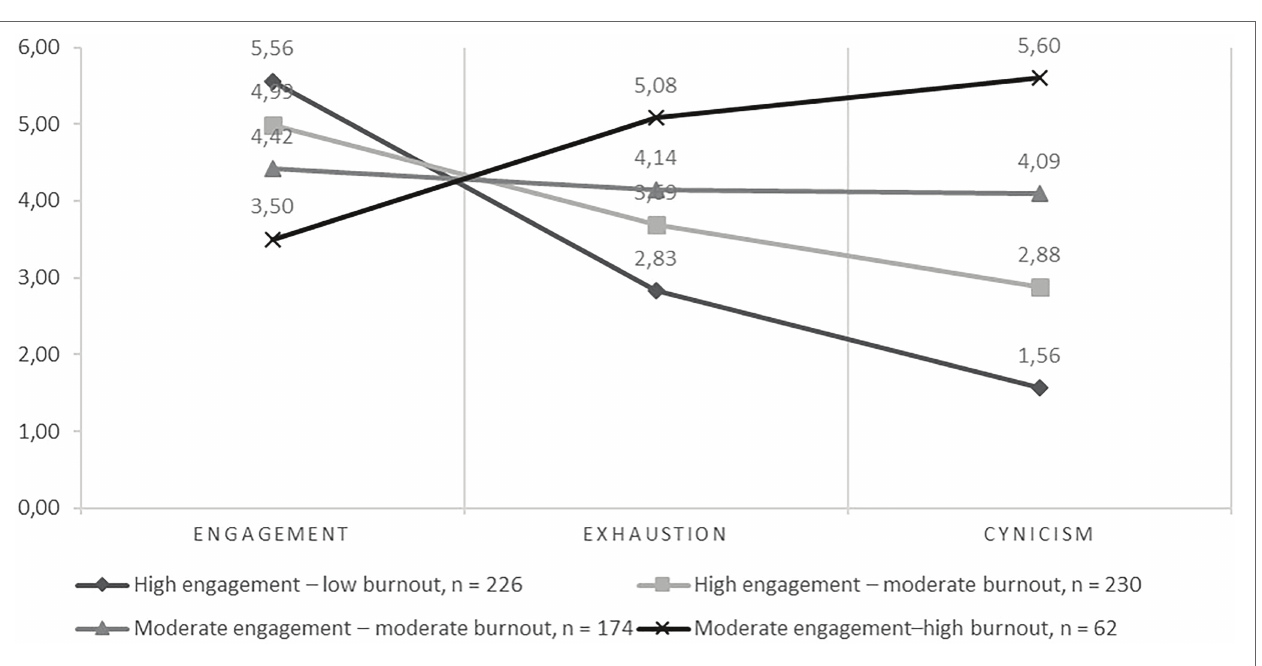
FIGURE 2 | Study well-being profiles of the PhD candidates in